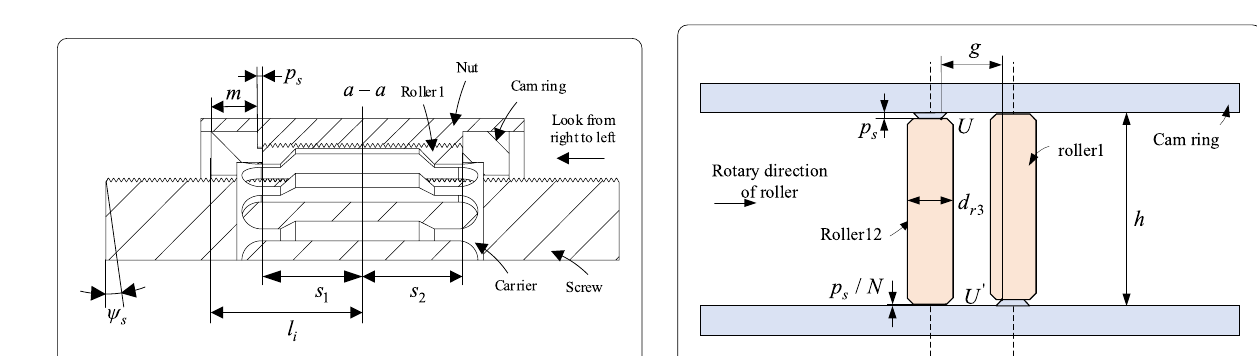
Figure 16 Cutaway view of roller assembly